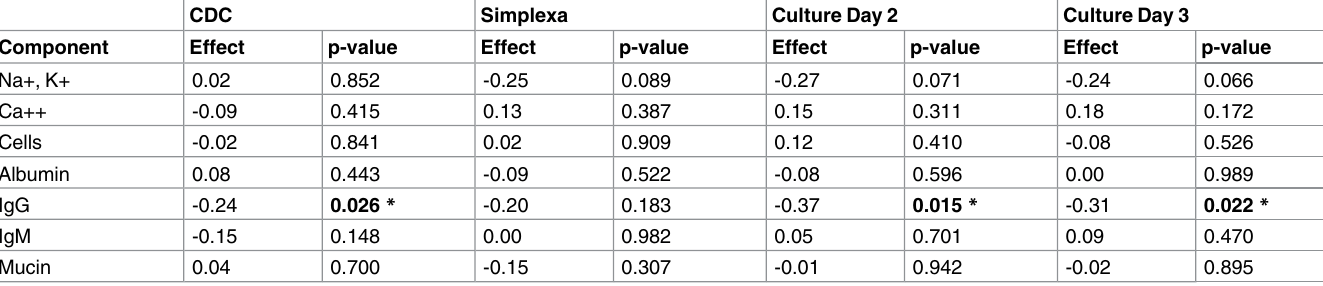
Table 4. Mean effect and p-values for the fractional factorial testing for the NAATs and virus